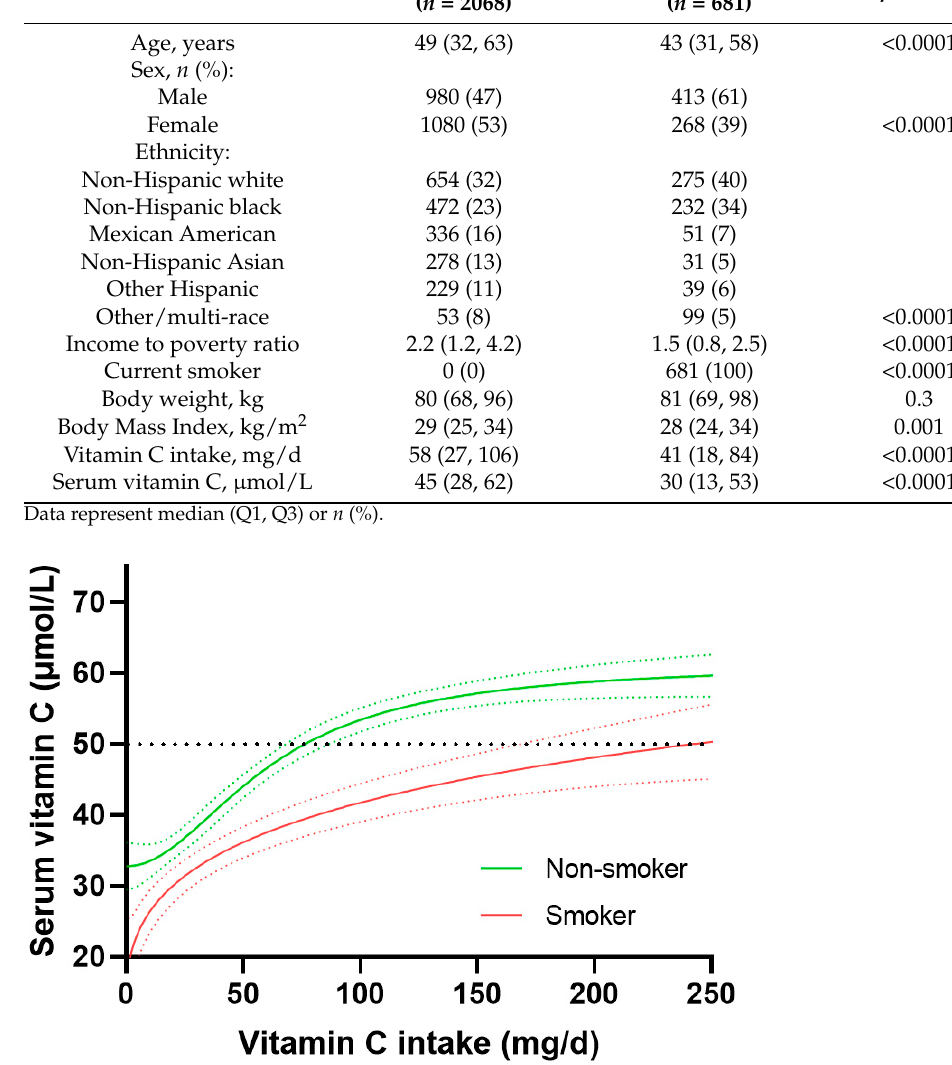
Figure 3. Vitamin C dose-response relationship relative to smoking status. Non-smoker n = 2068; smoker n = 681. Sigmoidal (four parameter logistic) curves were fitted to the dose-concentration data with asymmetrical 95% confidence intervals indicated. Dashed line indicates 50 µmol/L serum vitamin C, which is considered ‘adequate’.